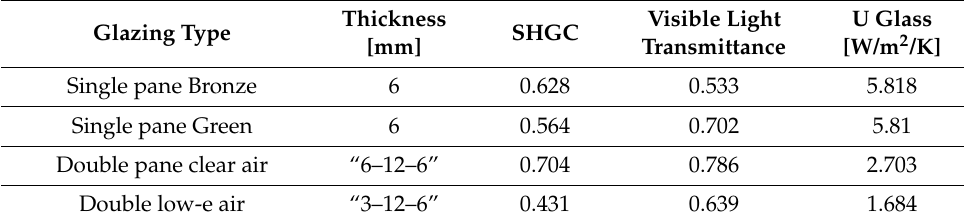
Table 4. List of all the external glazing